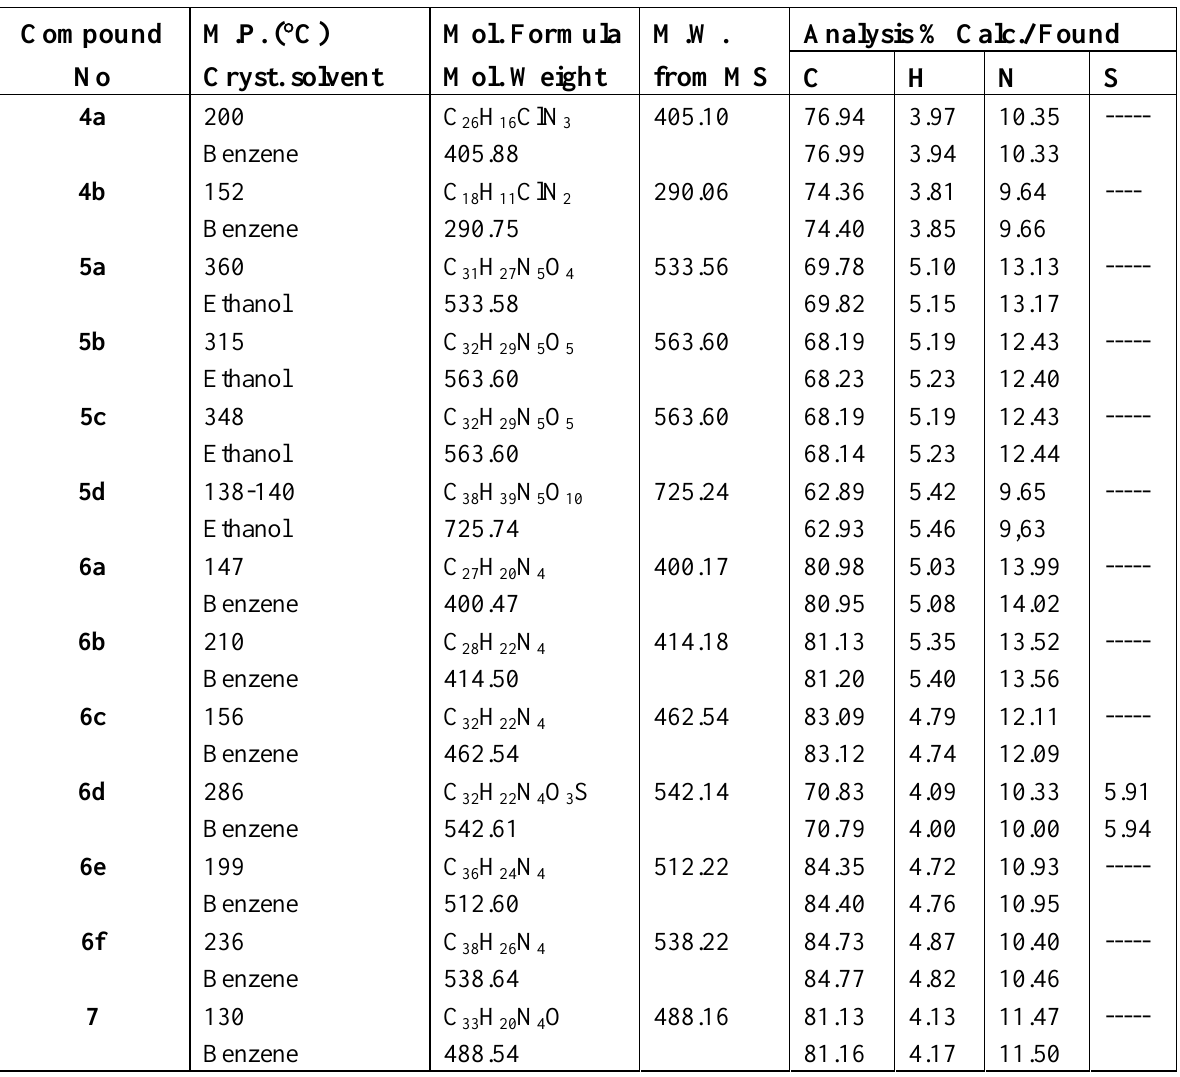
Table 2. Physical properties, mass spectral data and elemental analyses for compounds 4-7